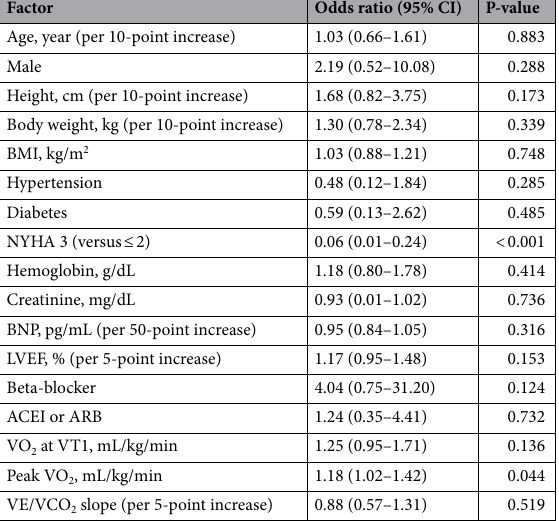
Table 3. Predictors of factors associated with response in the lactate sensor. ACEI angiotensin-converting enzyme inhibitor, ARB angiotensin receptor blocker, BMI body mass index, BNP B-type natriuretic peptide, CI confidence interval, LVEF left ventricular ejection fraction, NYHA New York Heart Association Functional Classification, VE/VCO